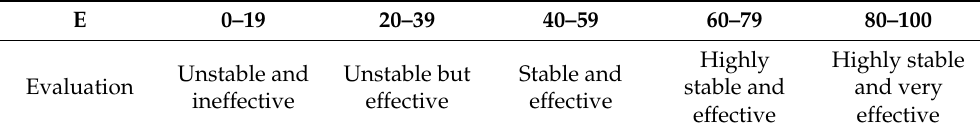
Table 8. Evaluation of LID facilities based on the developed weighted